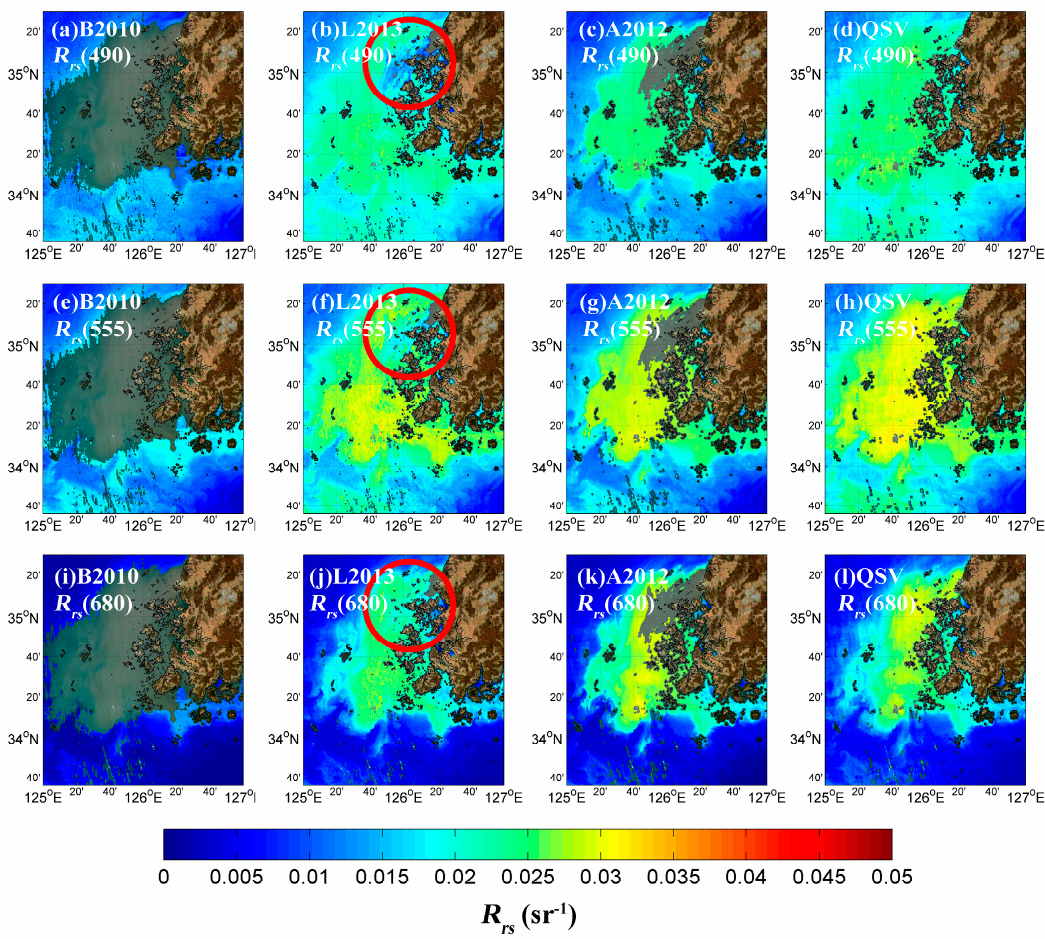
Figure 3. Comparisons of the R rs distributions (unit: sr − 1 ) at the ( a – d ) 490, ( e – h ) 555, and ( i – l ) 680 nm bands centered on the southwest coast of Korea on 14 March 2017 and processed by the B2010, L2013, A2012, and QSV algorithms. The regions in which the algorithms fail to make an AC because of highly turbid waters, or the presence of clouds and land are shown by the composed RGB pictures (B: 490 nm, G: 555 nm, and R: 680 nm). The unmasked abnormal low estimations from L2013 are highlighted by the red circles in panels ( b , f , j ).